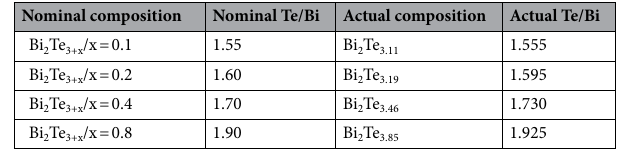
Table 1. The compositions and Te/Bi ratio of the Bi–Te thin films fabricated with a pre-deposited Cr layer at high substrate temperature.